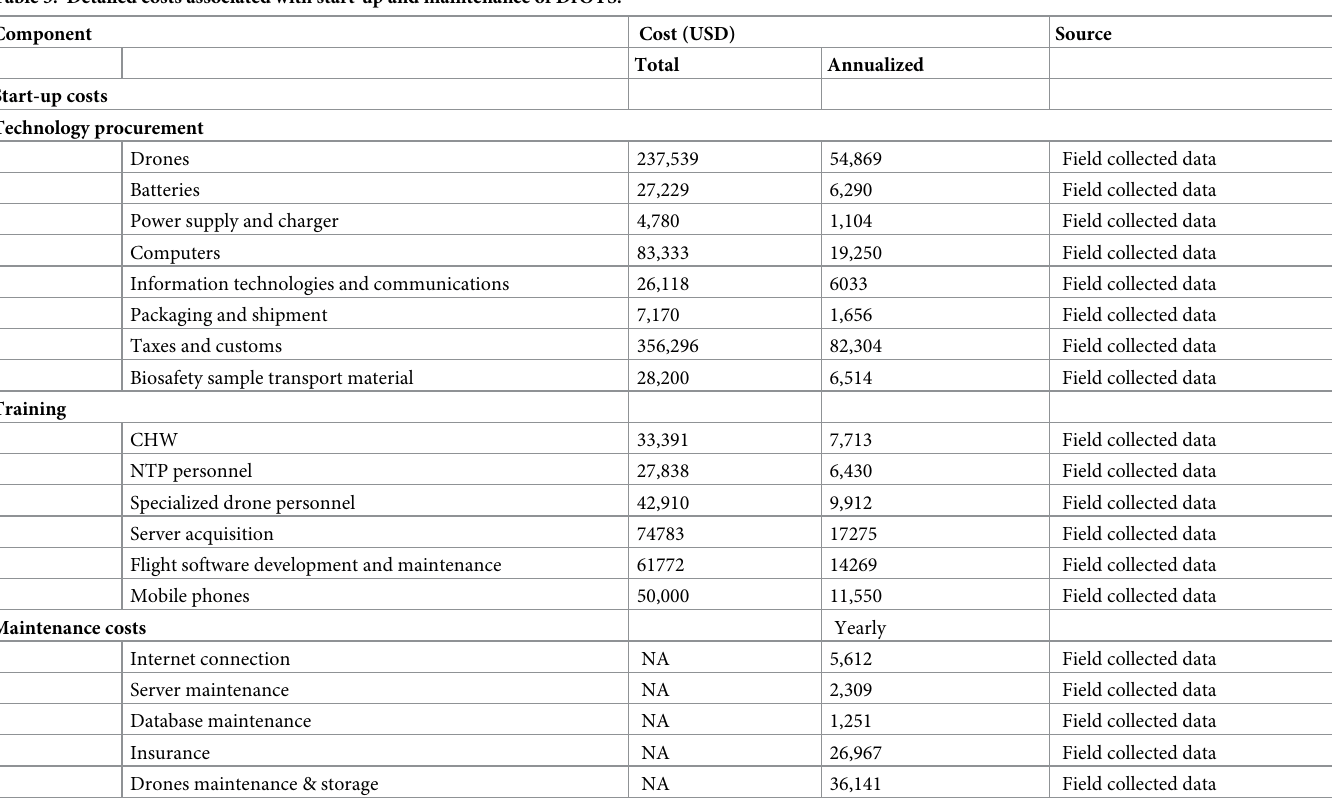
Table 3. Detailed costs associated with start-up and maintenance of